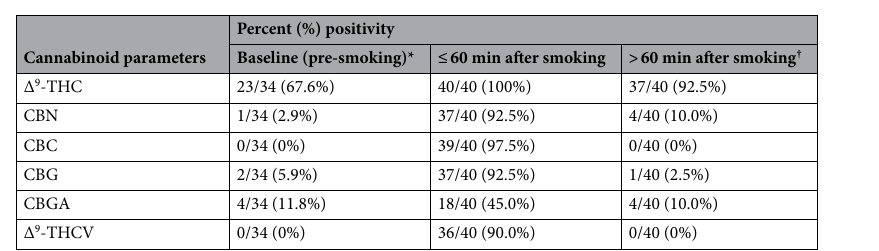
Table 2. Presence of key cannabinoids in exhaled breath before and after smoking. *Pre-smoking samples were not collected from 10 subjects. † No data beyond 60 min post-smoking in 4